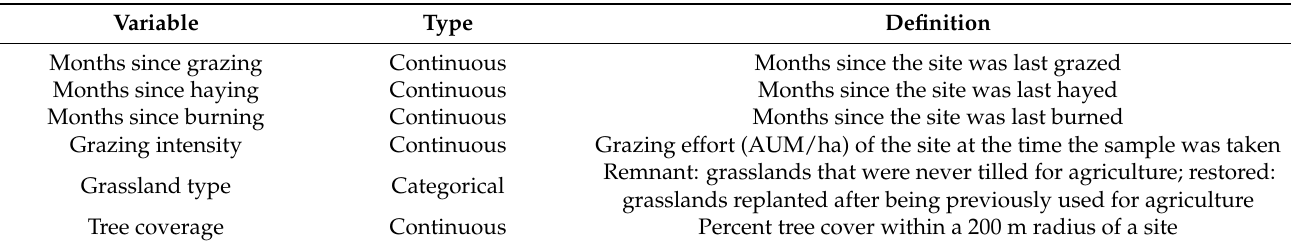
Table 1. Land management and habitat parameters tested as predictors of change in Bobolink abundance and/or productiv- ity between 2002 and 2019 on conservation grasslands in Nebraska, USA.